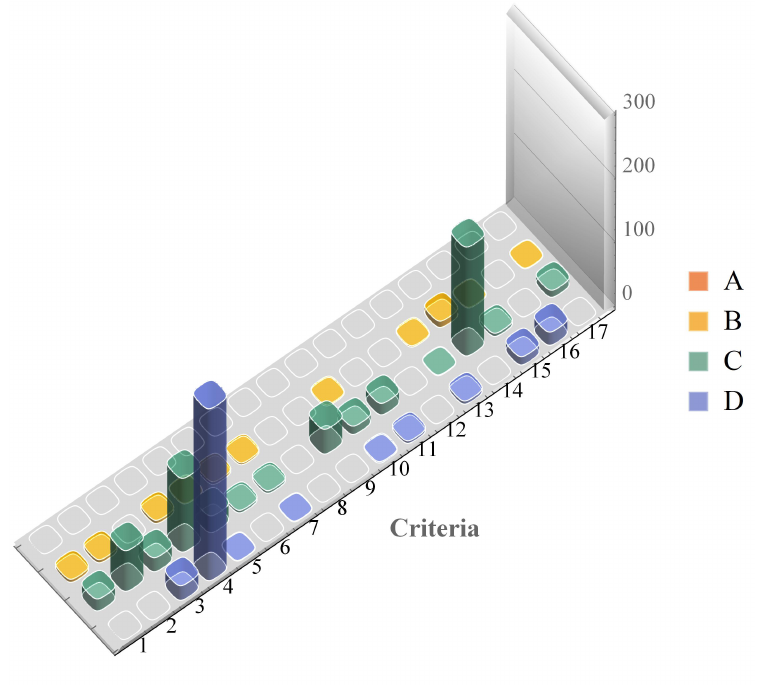
Figure 7. Class determining